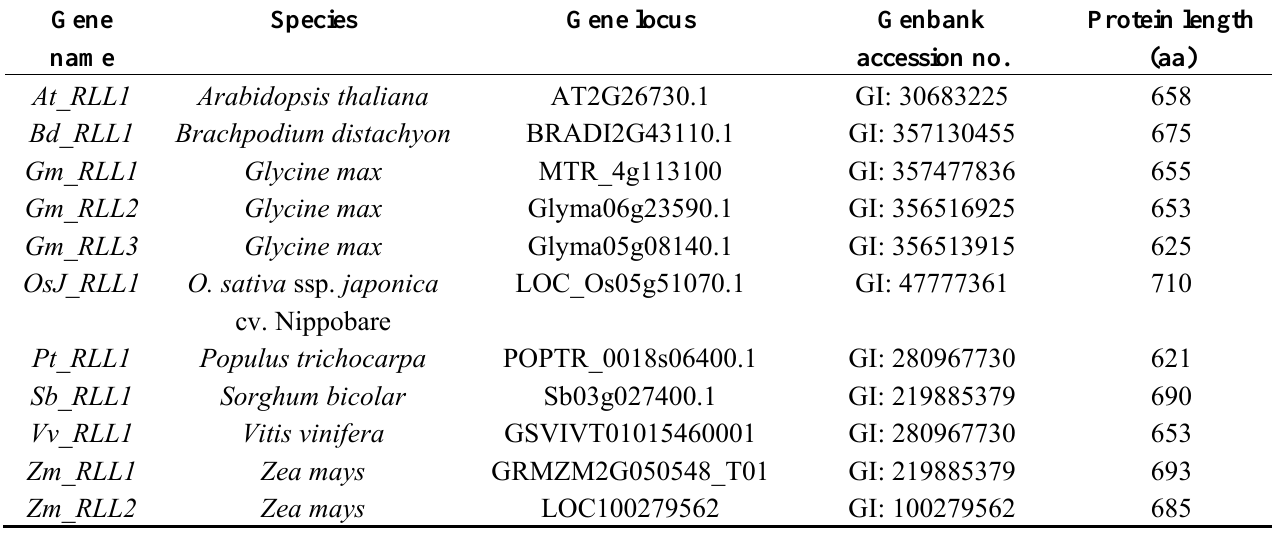
Table 2. Summary of gene features for orthologs OrufRPK1 and OsI219RPK1